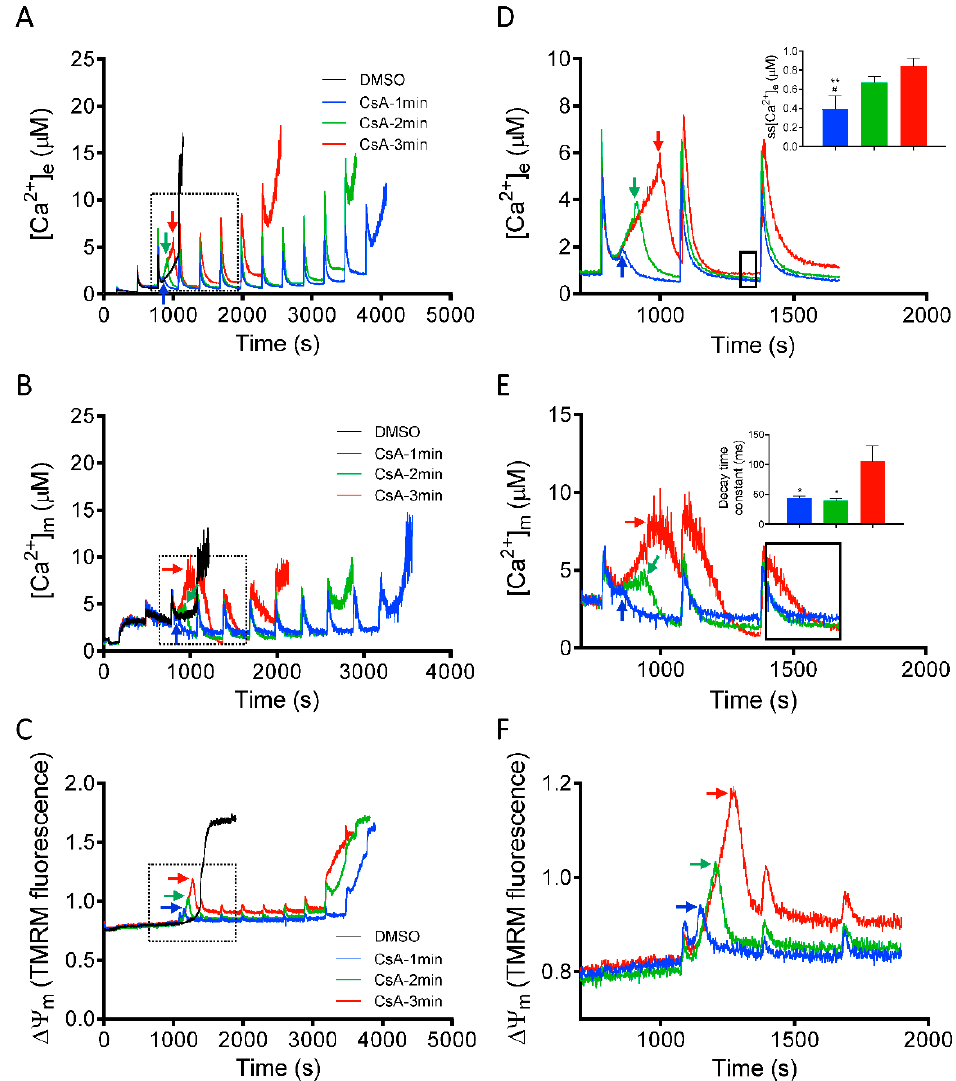
Figure 6. Time-dependent e ff ects of CsA on mitochondrial Ca 2 + dynamics and bioenergetics during rescue of mitochondria from mPTP opening. Changes in ( A ) extra-matrix free Ca 2 + ([Ca 2 + ] e ), ( B ) intra-matrix free Ca 2 + ([Ca 2 + ] m ) and ( C ) ∆Ψ m , when CsA was added at 1 min (blue trace), 2 min (green trace), and 3 min (red trace) after the last Ca 2 + bolus before another Ca 2 + bolus would have caused mPTP opening. Right panels show the e ff ect of CsA on ( D ) [Ca 2 + ] e , ( E ) [Ca 2 + ] m , and ( F ) ∆Ψ m dynamics during rescue of mitochondria from mPTP opening in greater detail. Insets ( D , E ) show relative ss[Ca 2 + ] e and decay time constant (ms) at specified time points (black dotted box), respectively. Arrows indicate time of addition of CsA (0.5 µ M). Error bars represent mean ± SEM (* p < 0.05, ** p < 0.01 vs. 3 min and # p < 0.05 vs. 2 min).